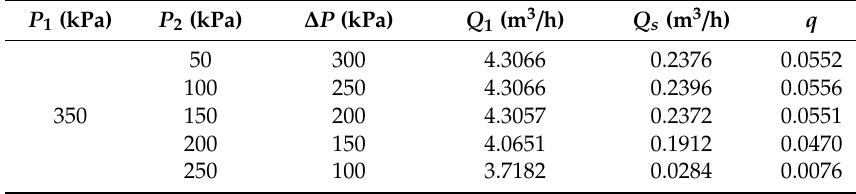
Table 4. Simulation results under conditions of P 1 = 350 kPa.